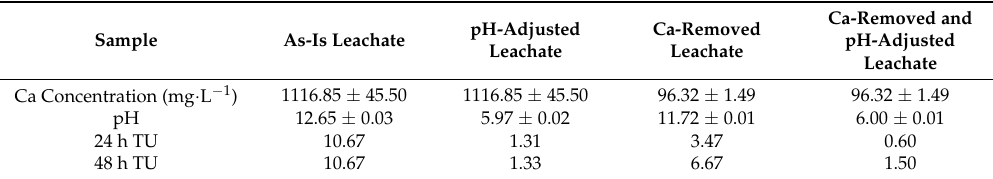
Table 5. Toxic units (TU) of the KSTM-SW leachates before and after adjusting pH or removing Ca determined by using Daphnia magna.